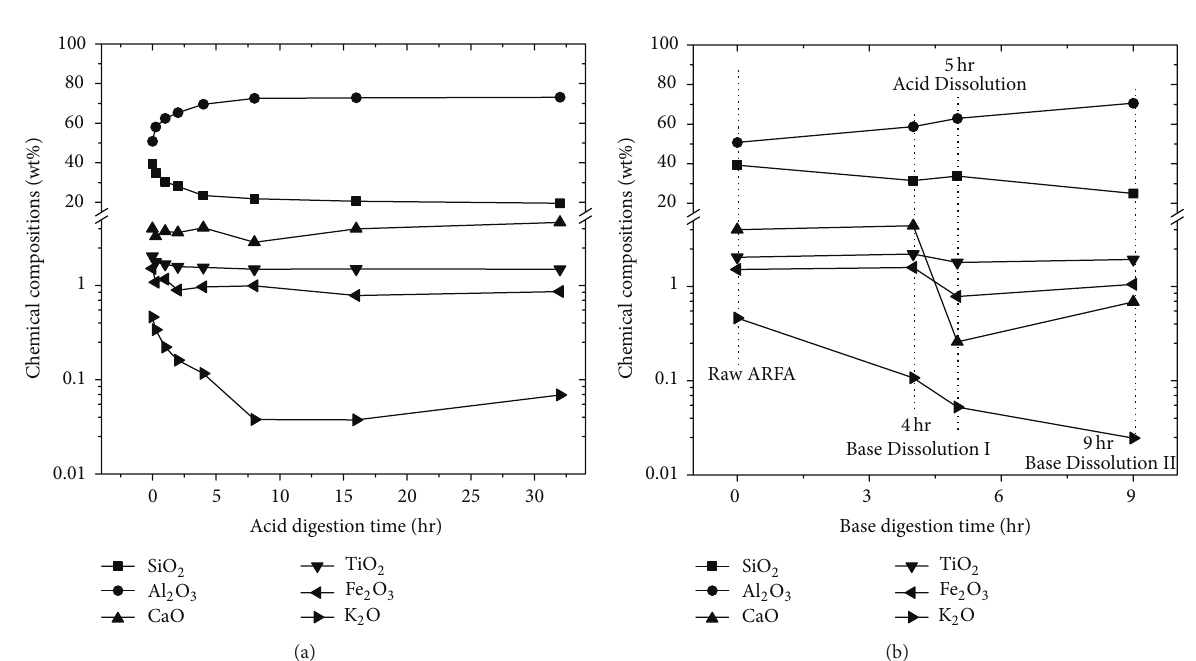
Figure 2: Chemical composition changes of ARFA by XRF in acid (a) and base (b) digestion